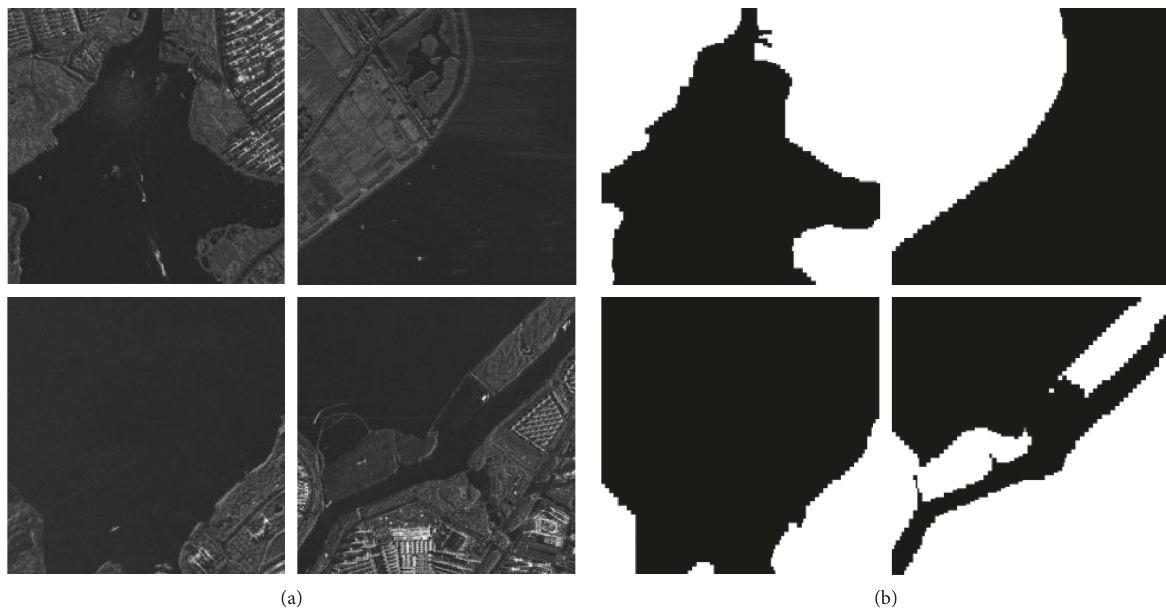
Figure 3: Training data and ground truths in sea-land segmentation dataset. (a) Training images. (b) Ground